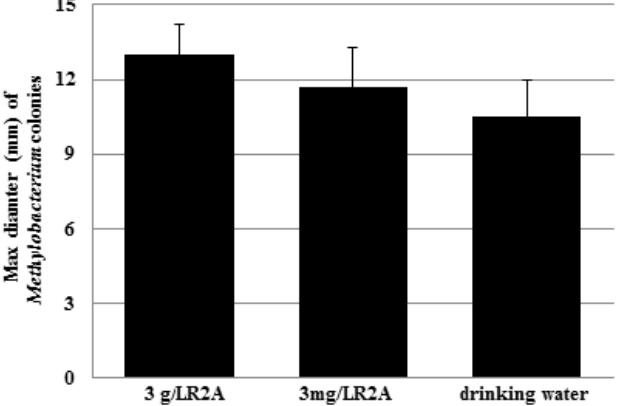
Figure 4. Maximum diameter of pure Methylobacterium colonies at 0.2% agar after 12 h of incubation at 28 °C.